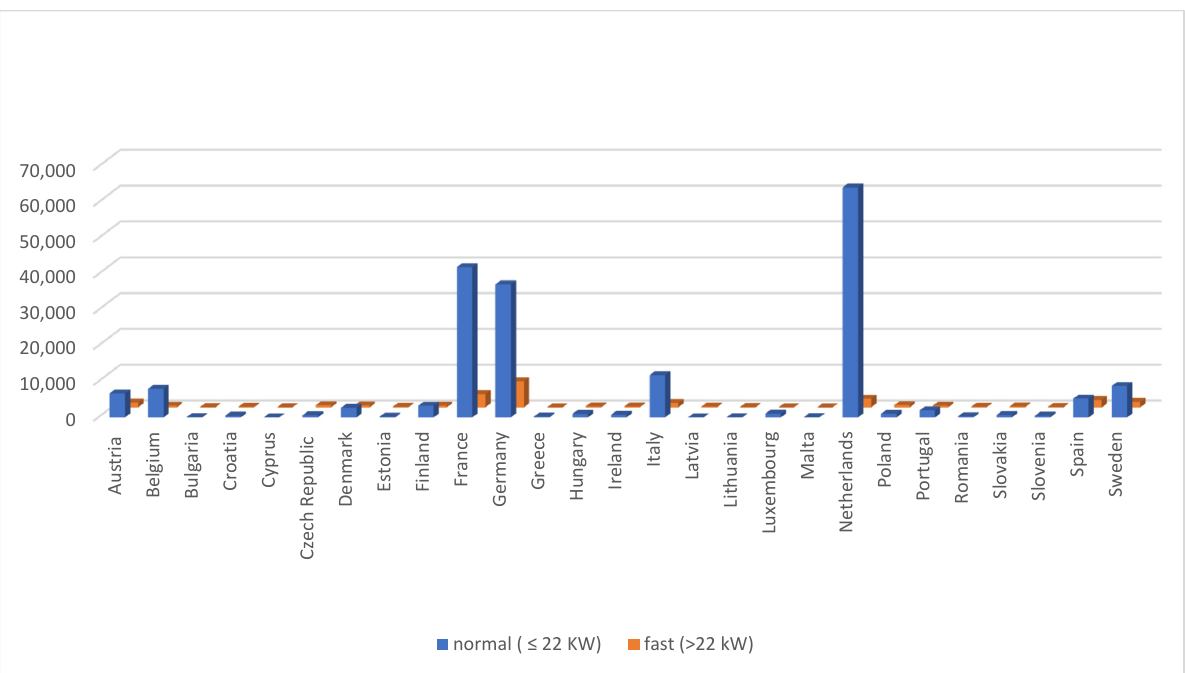
Figure 5. Normal and fast charging points in European Union (2020) [67].